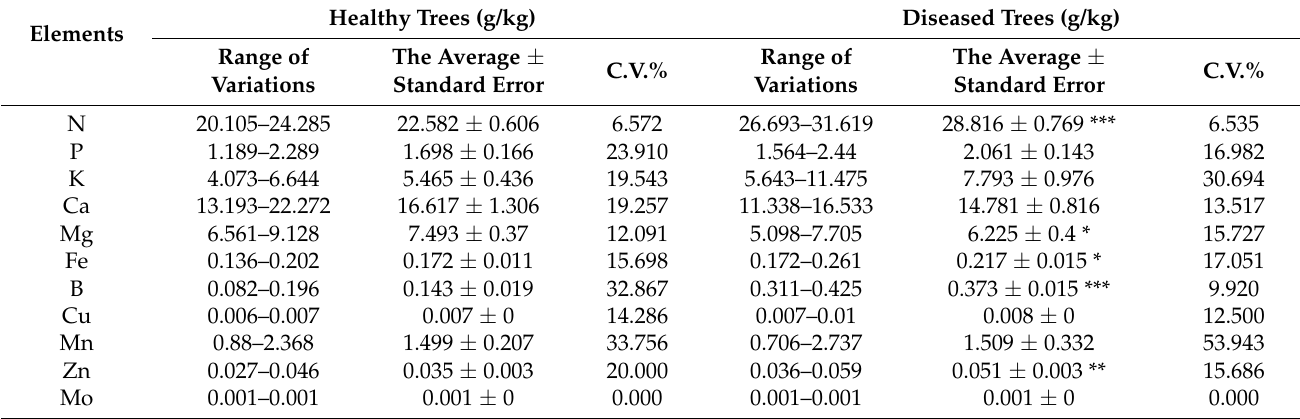
Table 1. Leaf nutrient elements in healthy and diseased chestnut